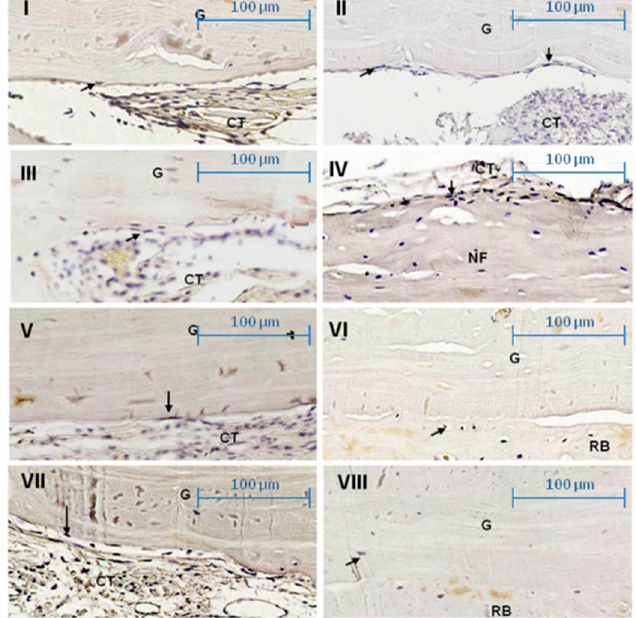
Figure 5. Photomicrographs showing the osteoblasts’ RANKL staining (arrows) on graft surface (G) at × 400 magnification. ( I ) Day 21 Group TOM: Moderate labeling. ( II ) Day 60 Group TOM: Mild labeling of osteoblasts. ( III ) Day 21 Group TO: Intense labeling of osteoblasts on newly formed bone (NF). ( IV ) Day 60 Group TO: Mild labeling of osteoblast. ( V ) Day 21 Group CS: Mild labeling of osteoblast. ( VI ) Day 60 Group CS: Mild labeling of osteoblast. ( VII ) Day 21 Group TS: Intense labeling of osteoblasts. ( VIII ) Day 60 Group TS: Mild labeling of osteoblasts. Receiver bed (RB), connective tissue (CT). Scale 100 µm.